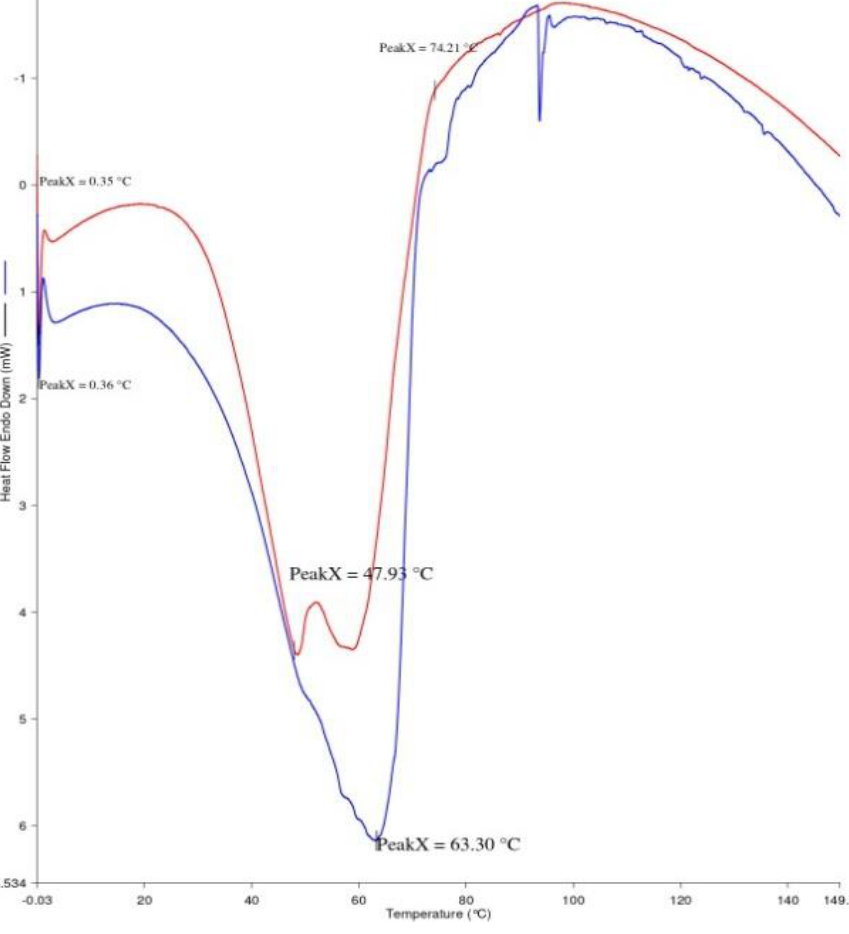
Figure 8. DSC thermogram of LcrV (red) and PD1 formulation (blue) after 3 weeks.